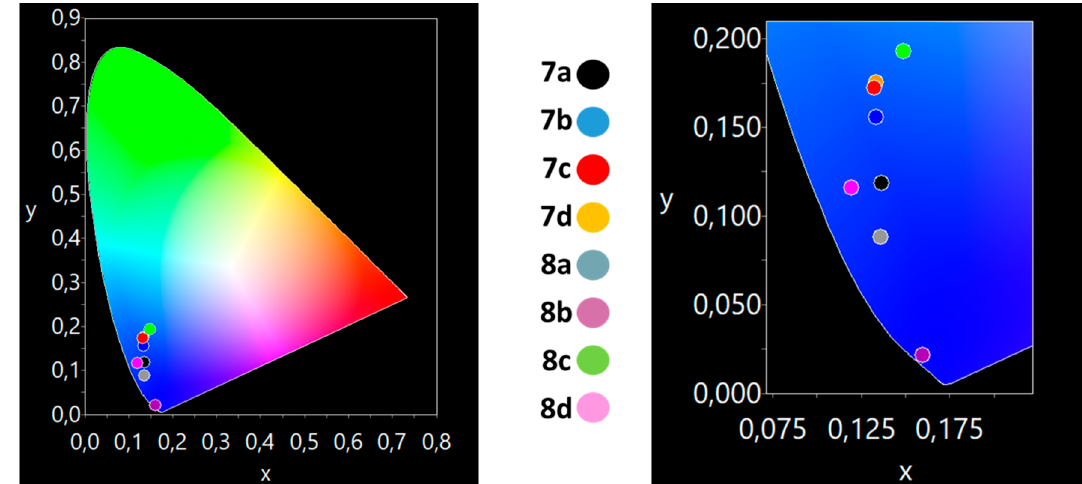
Figure 6. The CIE coordinates for the compounds 7a – d and 8a – d in DMSO solution, showing the deep-blue color of 8b .